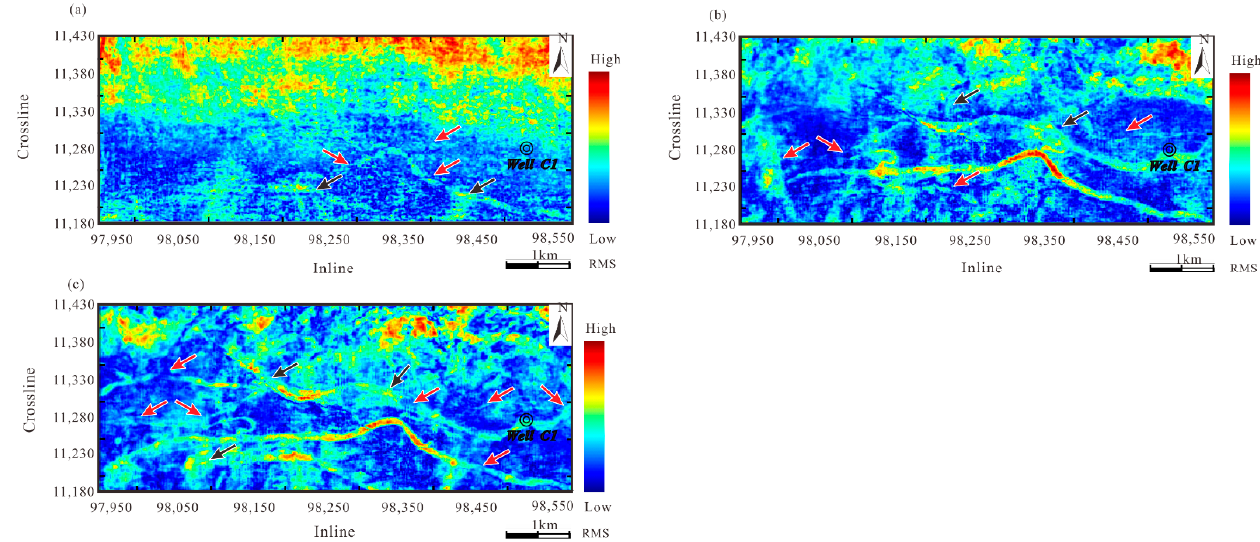
Figure 9. The RMS amplitude slices at t = 1650 ms. ( a – c ) show the RMS amplitude from the three frequency bands: ( a ) 10~33 Hz; ( b ) 34~57 Hz; ( c ) 58~81 Hz calculated by STFT method.